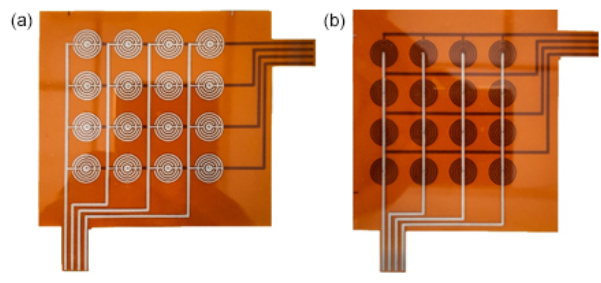
Figure 1. Electrode matrix design: silver electrodes on polyimide foil – upper side (a) and reverse side (b) .